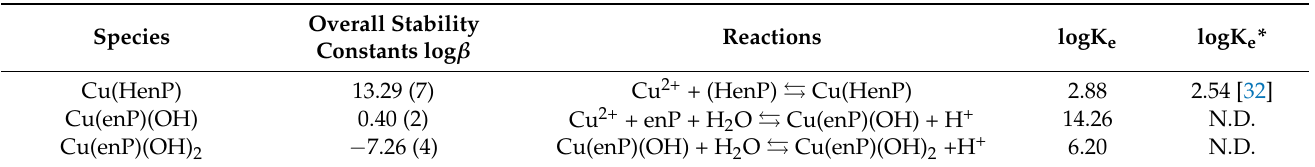
Table 4. Protonation constants of enP, overall and successive stability and equilibrium constants of Cu(II) complexes (standard deviation is given in parenthesis).